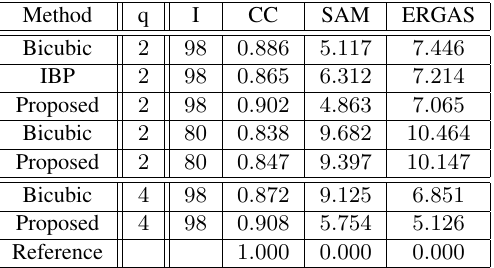
Table 1: Quantitative comparison of SR results on AVIRIS data for q=2 and